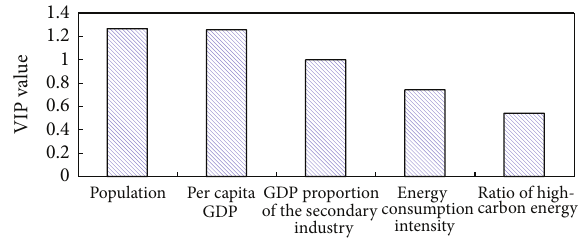
Figure 7: VIP values of different factors of carbon emissions from energy consumption of Shandong